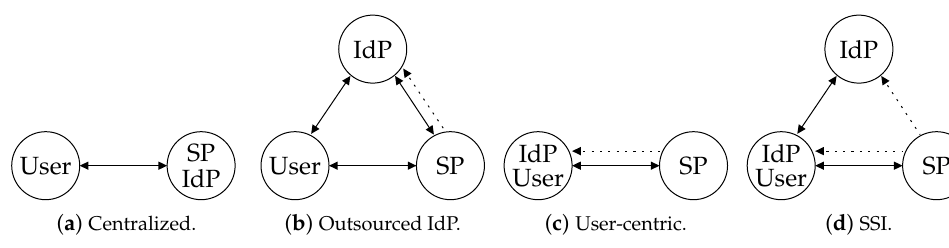
Figure 1. The IAM models. Constant lines represent interactions, and dashed lines mean